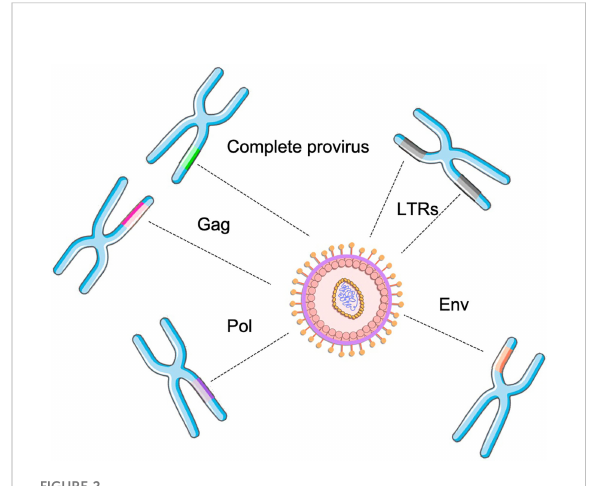
FIGURE 2 HERV assembly determined by the combination of distinct retroviral genes (solo or from complete proviruses) from different genomic locations within the